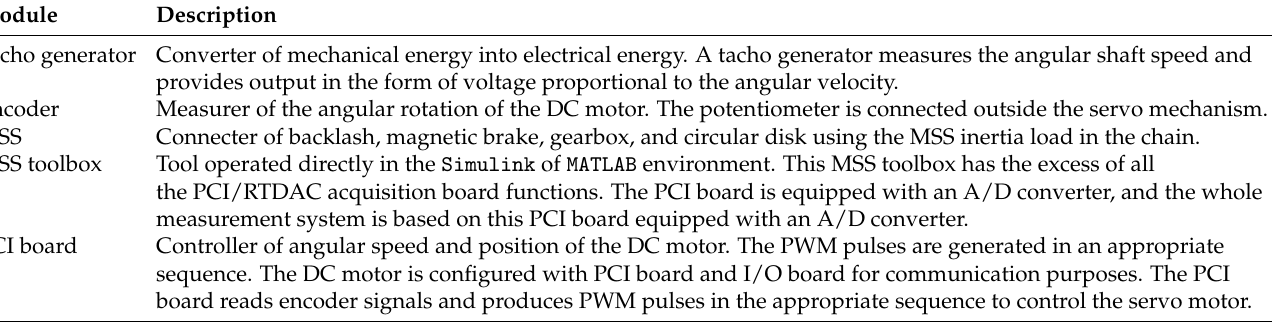
Table 10. Modules of the DC servo mechanism.